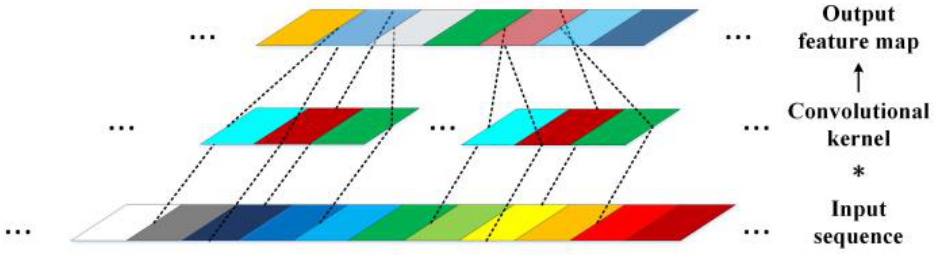
Figure 6. The sketch of convolution.